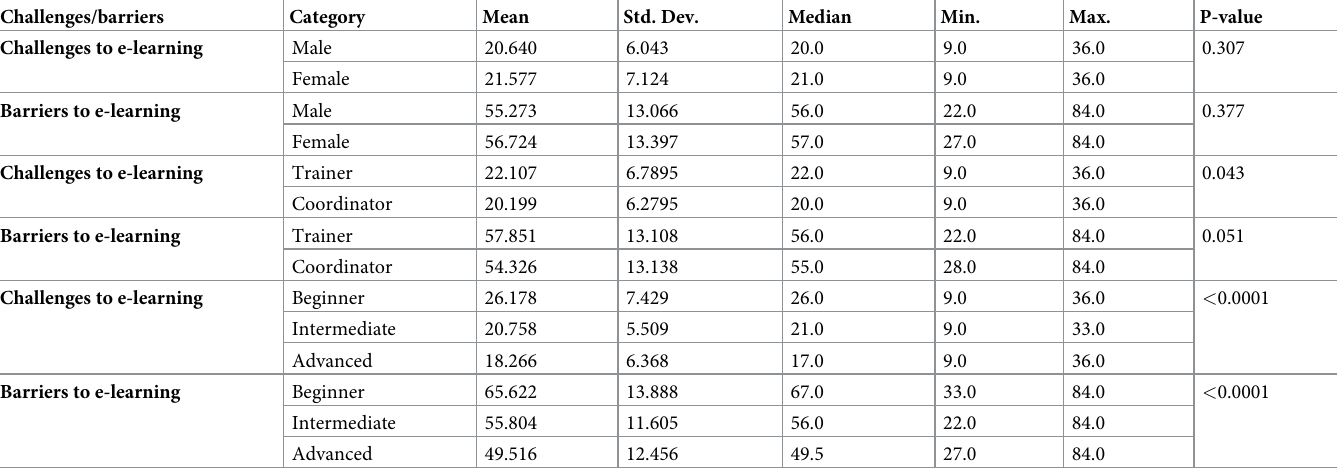
Table 4. Challenges and barriers to e-learning in relation to participant data.